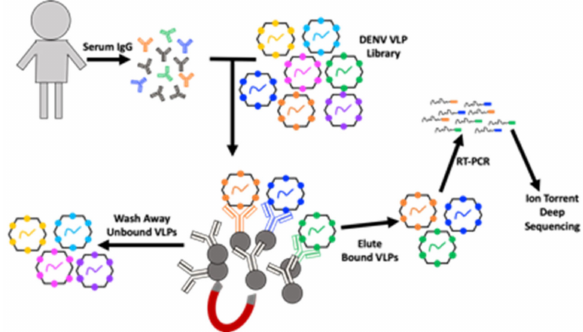
Figure 1. Schematic showing the workflow for our modified deep sequence-coupled biopanning (DSCB) approach. IgG was isolated from human serum and mixed with an MS2 virus-like particle (VLP) library displaying all possible 10-amino acid peptides from the dengue virus (DENV) polypeptide. Protein-G coupled to magnetic beads are used to pull down antibody–VLP complexes. Bound VLPs are eluted, RNA is extracted, and RT-PCR is used to produce cDNA, which is then subjected to Ion Torrent deep sequencing.